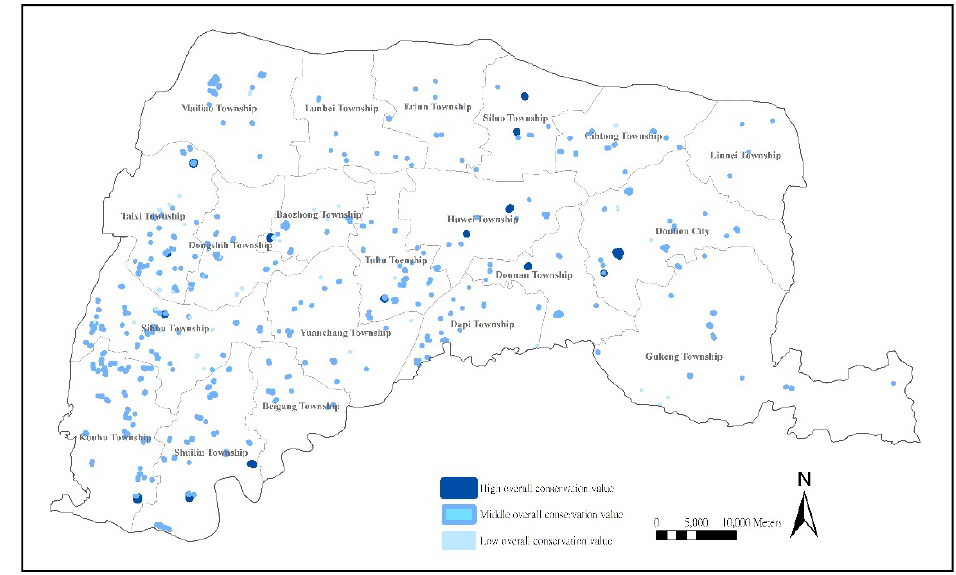
Figure 7. Distribution of farm ponds with overall preservation